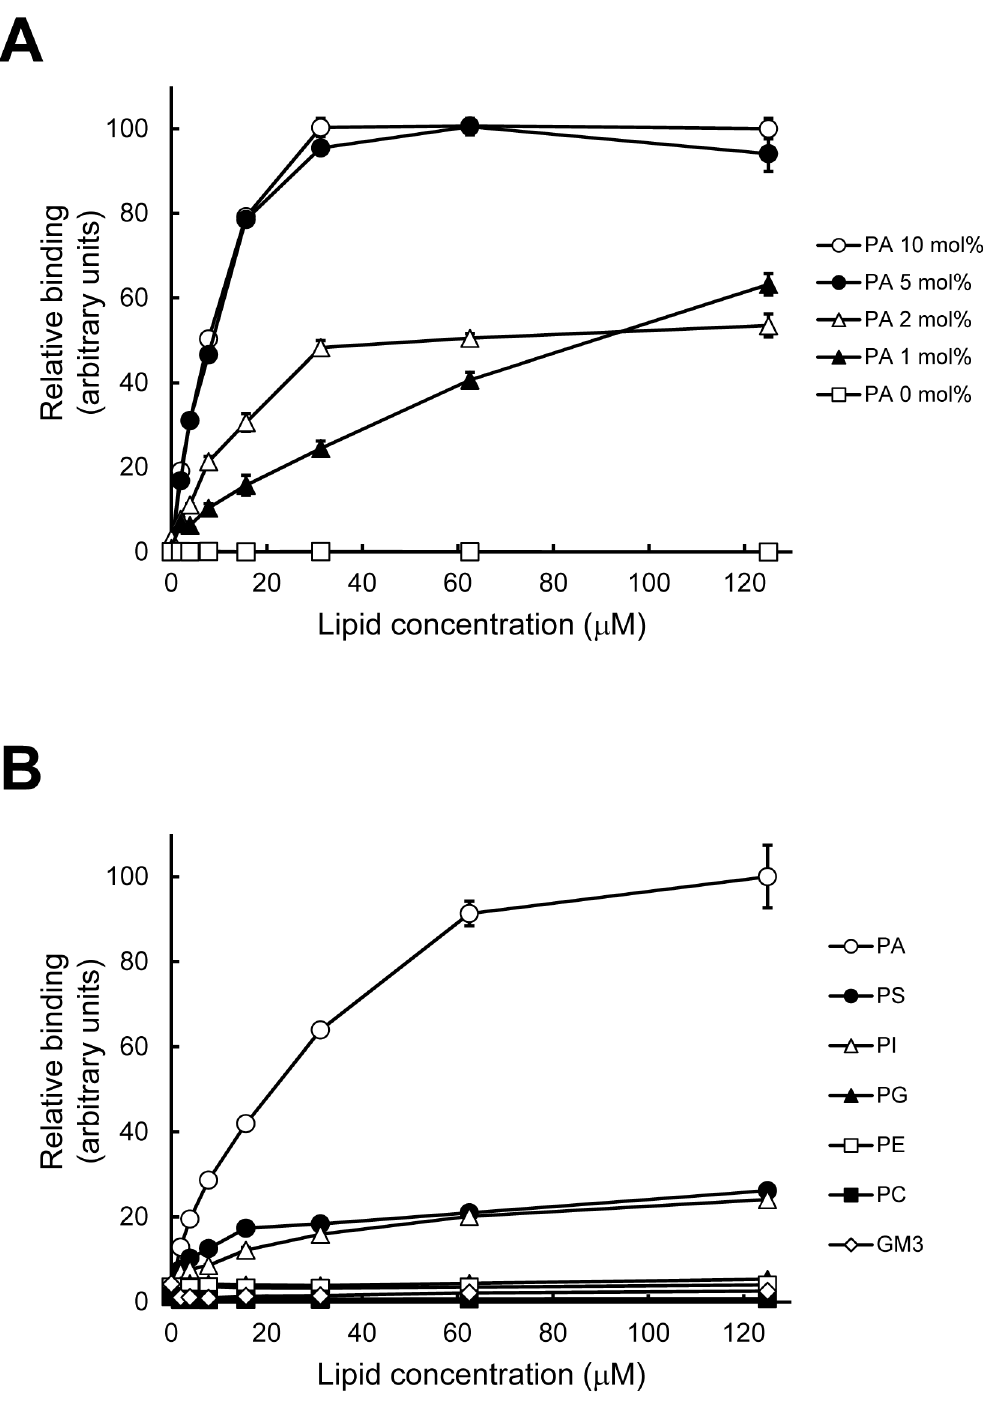
Fig 2. Analysis of binding of PAB-TP to phospholipids by the solid phase vesicle-binding assay. (A) Binding of PAB-TP to LUVs composed of DOPA/ DOPC/biotin-DOPE/cholesterol (10:58:2:30), (5:63:2:30), (2:66:2:30), (1:67:2:30), and (0:68:2:30) was examined by the SPVB assay (mean ± SE, n = 3). (B) Binding of PAB-TP to LUVs composed of DOPC, biotin-DOPE, cholesterol, and indicated lipid (58:2:30:10) was examined by the SPVB assay (mean ± SE, n = 3). (A, B) The binding of LUVs composed of DOPA/DOPC/biotin-DOPE/cholesterol (10:58:2:30) at the concentration of 125 μ M to PAB-TP was represented as 100 (arbitrary